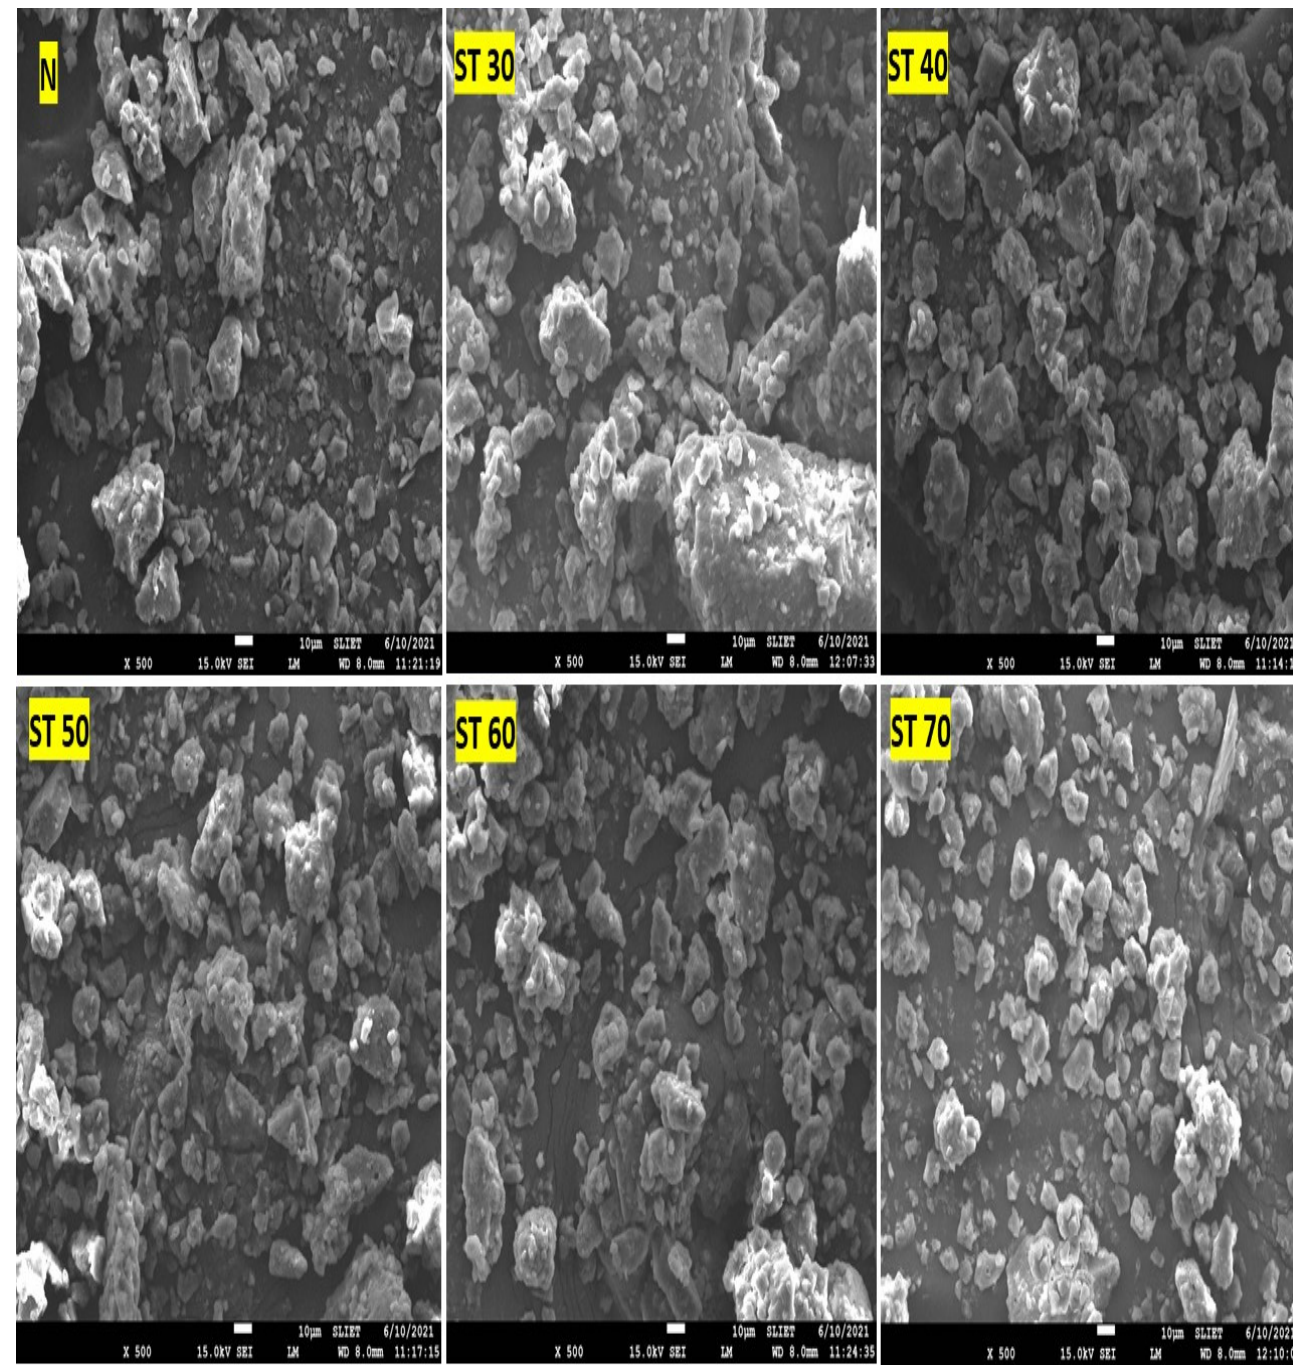
Figure 3. SEM micrographs of N: native plum kernel protein isolate; ST 30: supercritical carbon dioxide (SC-CO 2 )-treated plum kernel protein isolate at 30 °C; ST 40: SC-CO 2 -treated plum kernel protein isolate at 40 °C; ST 50: SC-CO 2 -treated plum kernel protein isolate at 50 °C; ST 60: SC-CO 2 - treated plum kernel protein isolate at 60 °C and ST 70: SC-CO 2 -treated plum kernel protein isolate at 70 °C.